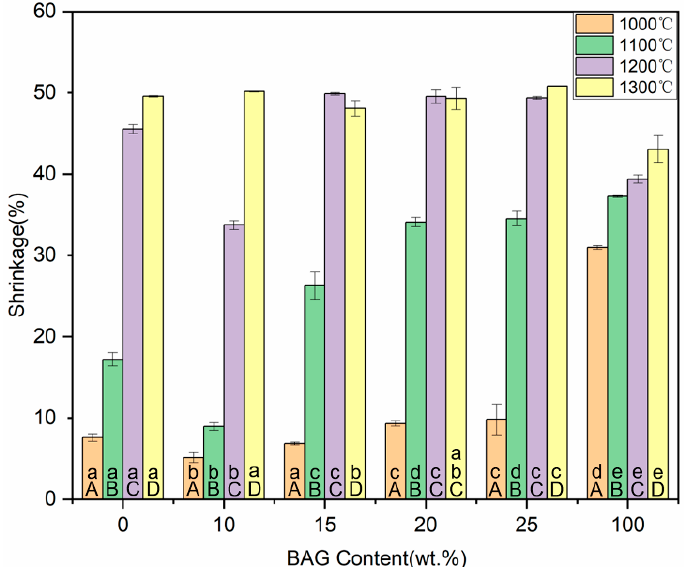
Figure 8. Shrinkage of ceramics with different sintering temperatures and different BAG contents. a